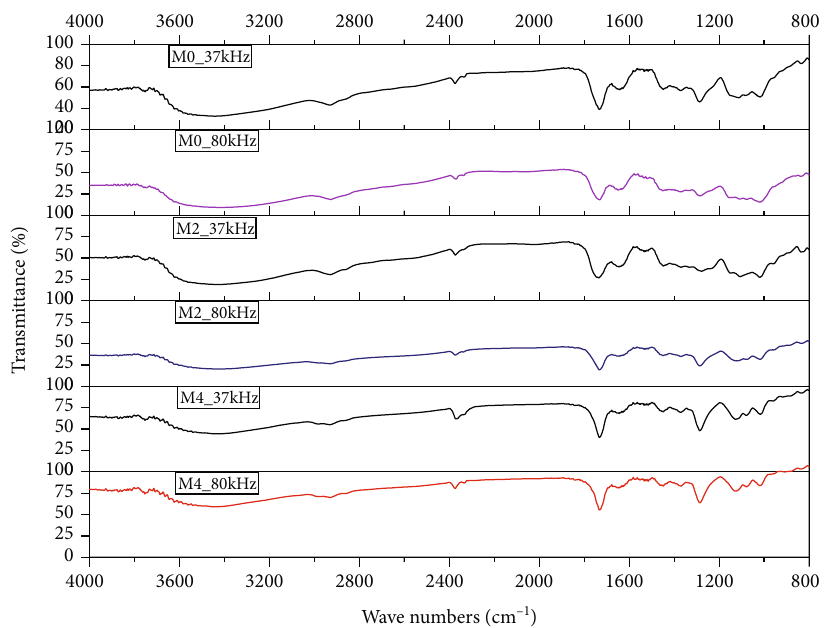
Figure 4: FTIR spectrum of pectin extracted from mango peel after 20 min, di ff erent maturity stages (M0, M2, and M4), and ultrasonic pretreatment frequency (37 kHz and 80kHz).